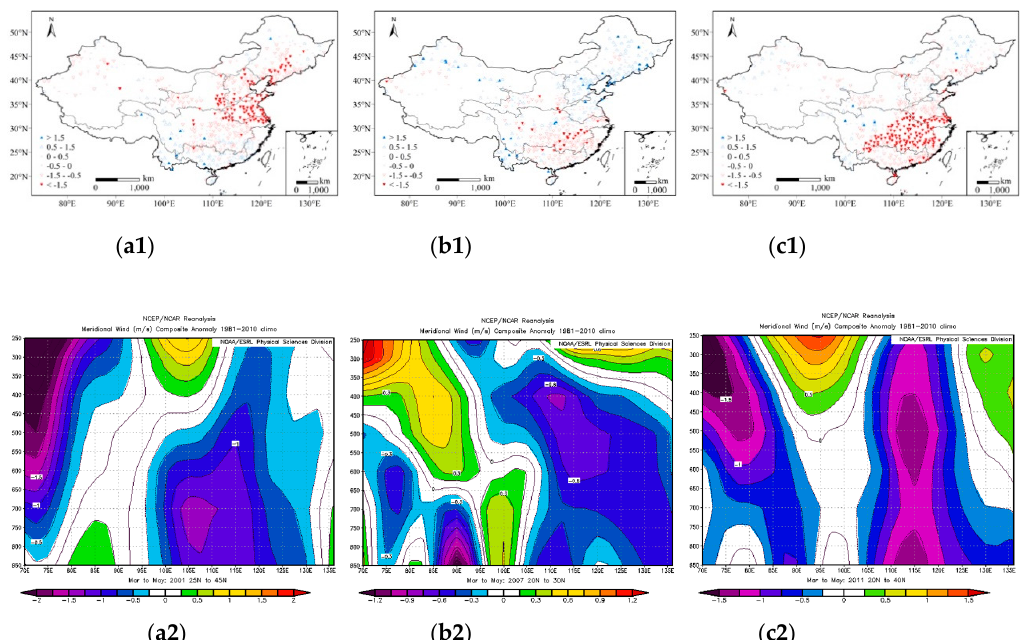
Figure 2. Spring extreme droughts and composite anomaly of meridional wind (m/s) at the corresponding areas in 2001 ( a1 / a2 ), 2007 ( b1 / b2 ), and 2011( c1 / c2 ).